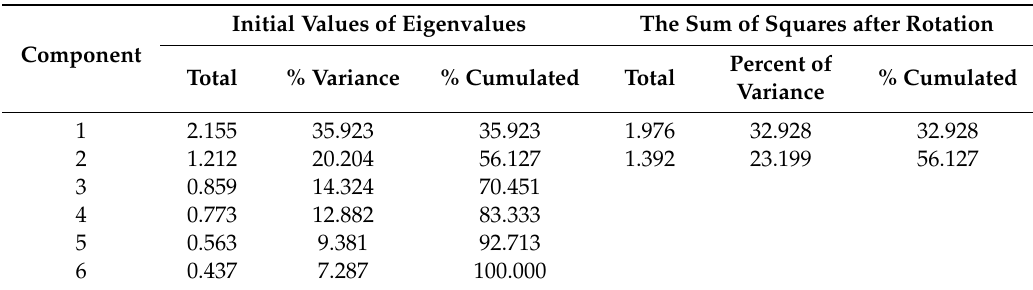
Table 11. Identification of two components of Customer Communication Complexity